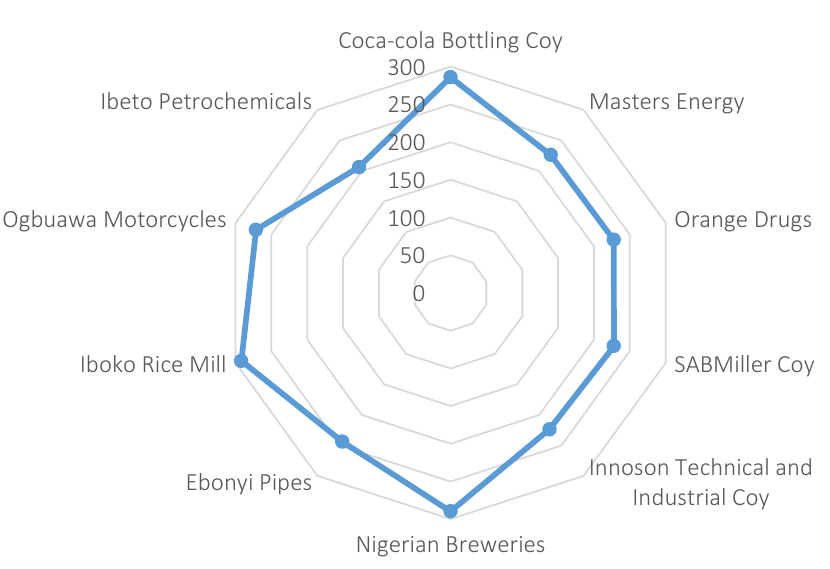
Figure 1. “Focus level” mean rank by Firm type